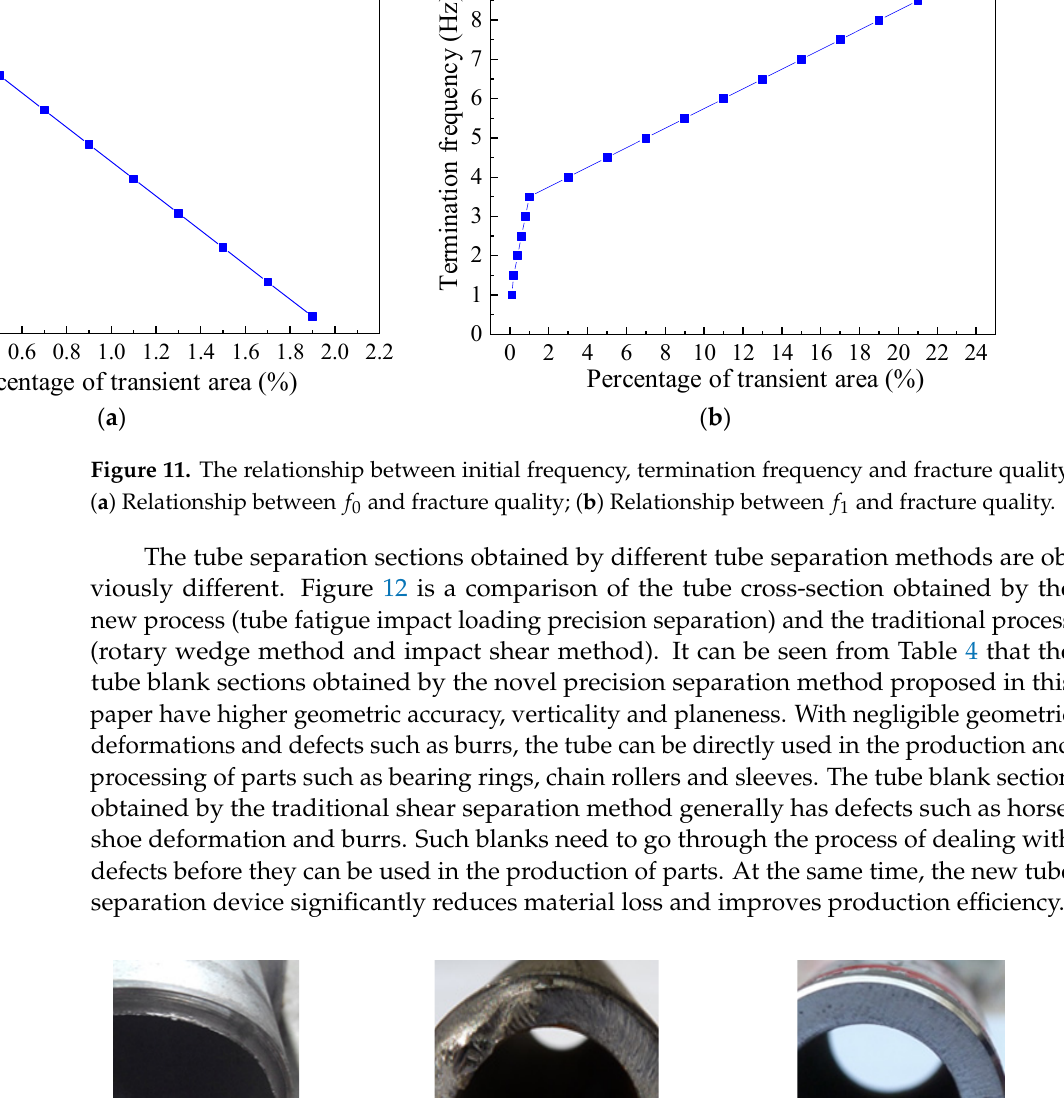
f and fracture 1